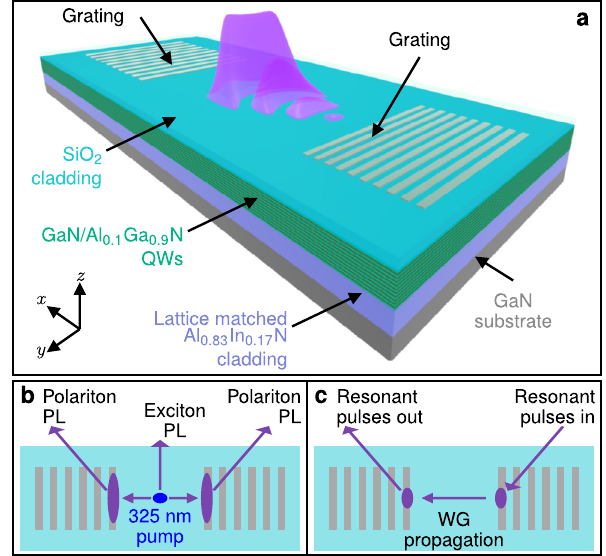
Fig. 1 Sample and experimental schematics. a Schematic of AlInGaN polariton waveguide (WG) structure. b Excitation and detection schematic for photoluminescence (PL) measurements. Hot carriers are excited by 325 nm laser light. Polariton states are populated by luminescence, propagate to the grating couplers, and are diffracted out. c Excitation and detection schematic for nonlinear measurements. Pulses are resonantly coupled to the waveguide mode at one grating coupler, propagate in an unpatterned region between the couplers, and are diffracted out at a second